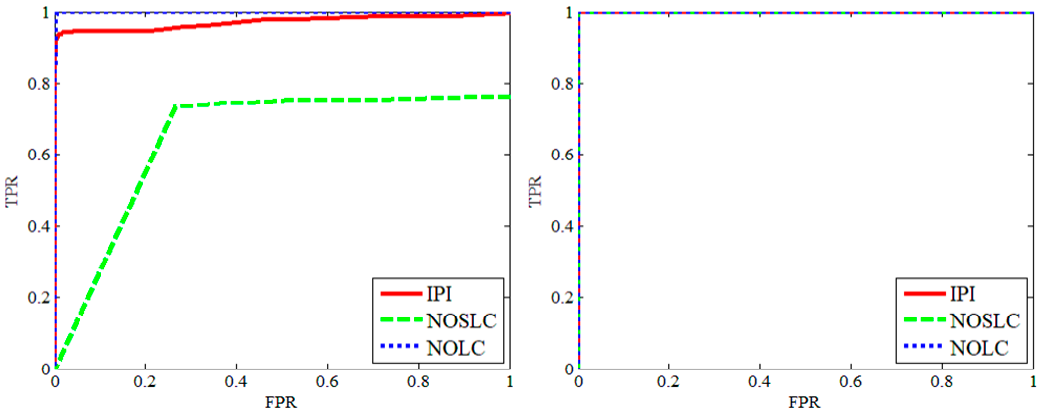
Figure 10. ROC curves for IPI, NOSLC and NOLC.